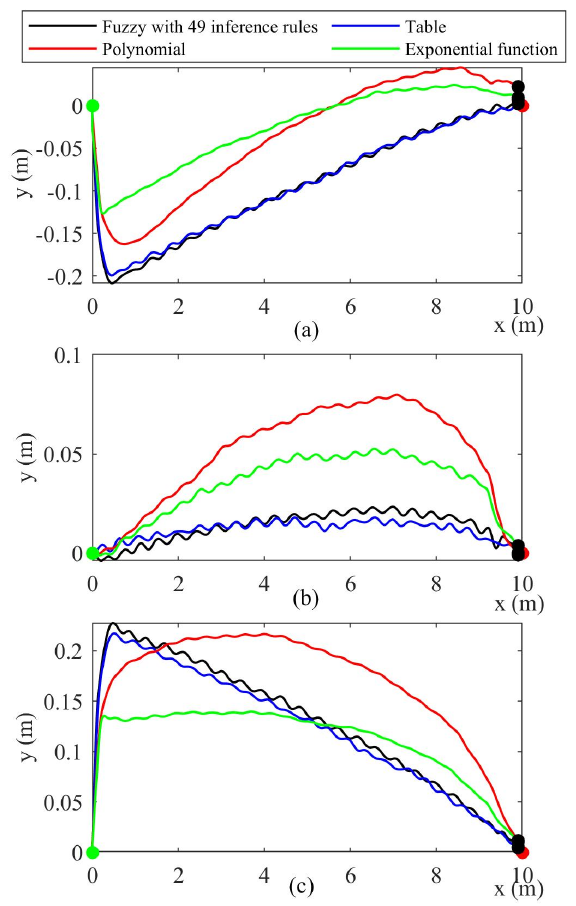
Figure 17. Mobile robot trajectories in real-world conditions for individual control methods with a maximum speed of both engines of 60% and an initial mobile robot angle of deflection from the target position: ( a ) − 90°; ( b ) 0°; ( c ) 90°.